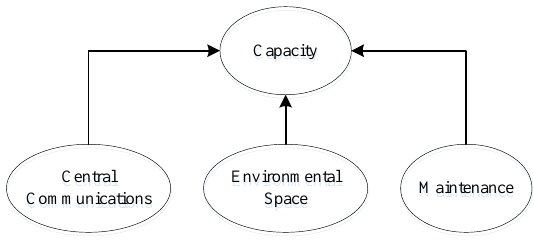
Figure 4. Example constraints on the maximum number of robots needed.